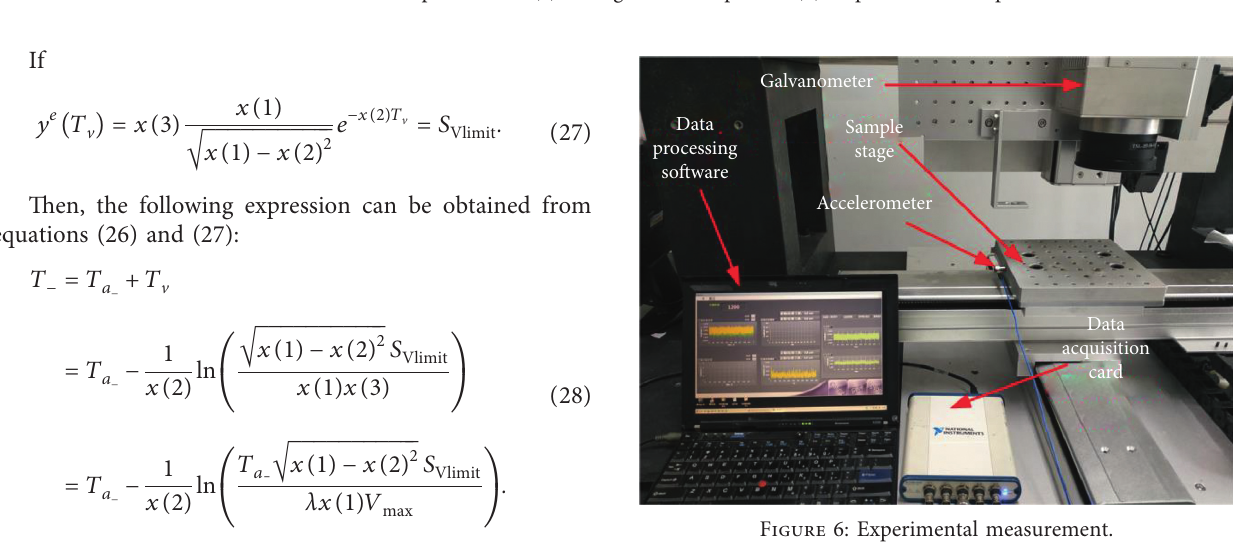
Figure 5: Two different impact forms. (a) Triangular move profile; (b) trapezoidal move profile.